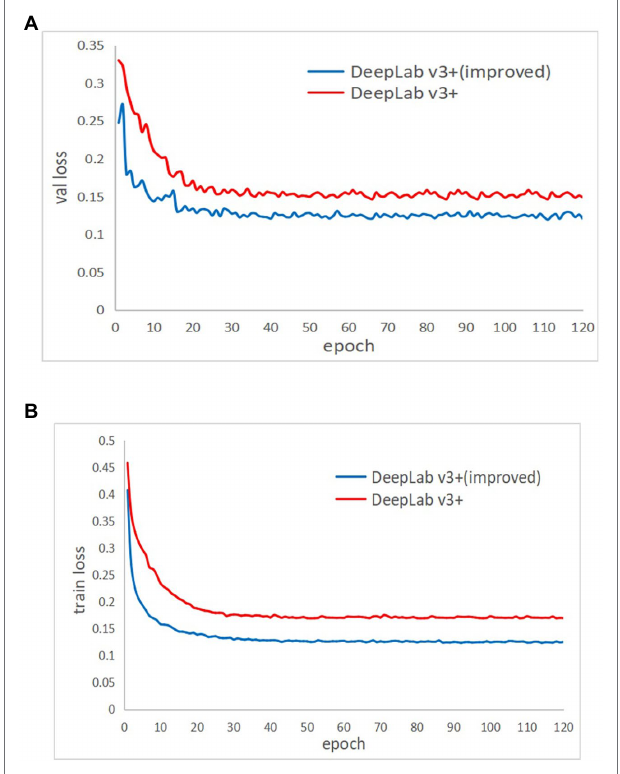
FIGURE 10 | Comparison of the training results of the network before and after the improvement of DeepLab v3+. (A) The training set, (B) the validation